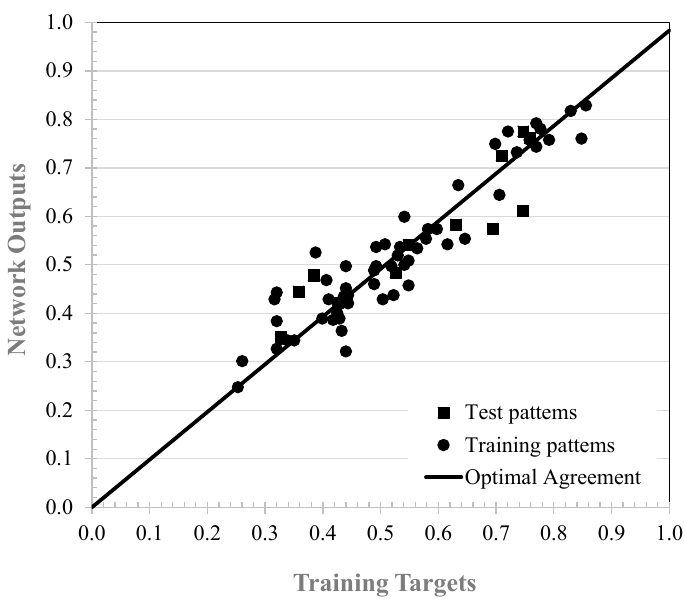
Figure 7. Scatter comparison of targets vs. network outputs.